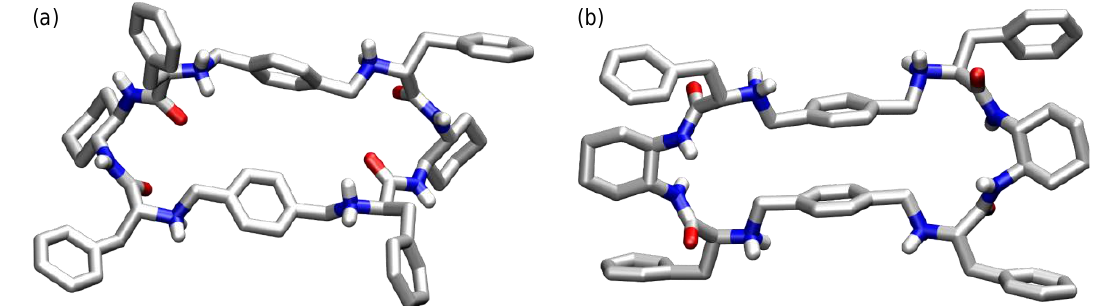
Figure 14. Crystal structures of the phenylalanine-derived analogs of 32 ·4HCl (CSD Entry: QOJREN) ( a ) and 33 ·4HCl (CSD Entry: EHEMAG) ( b ). Solvent molecules, counterions, and protons, except acidic ones, are omitted for reasons of clarity.